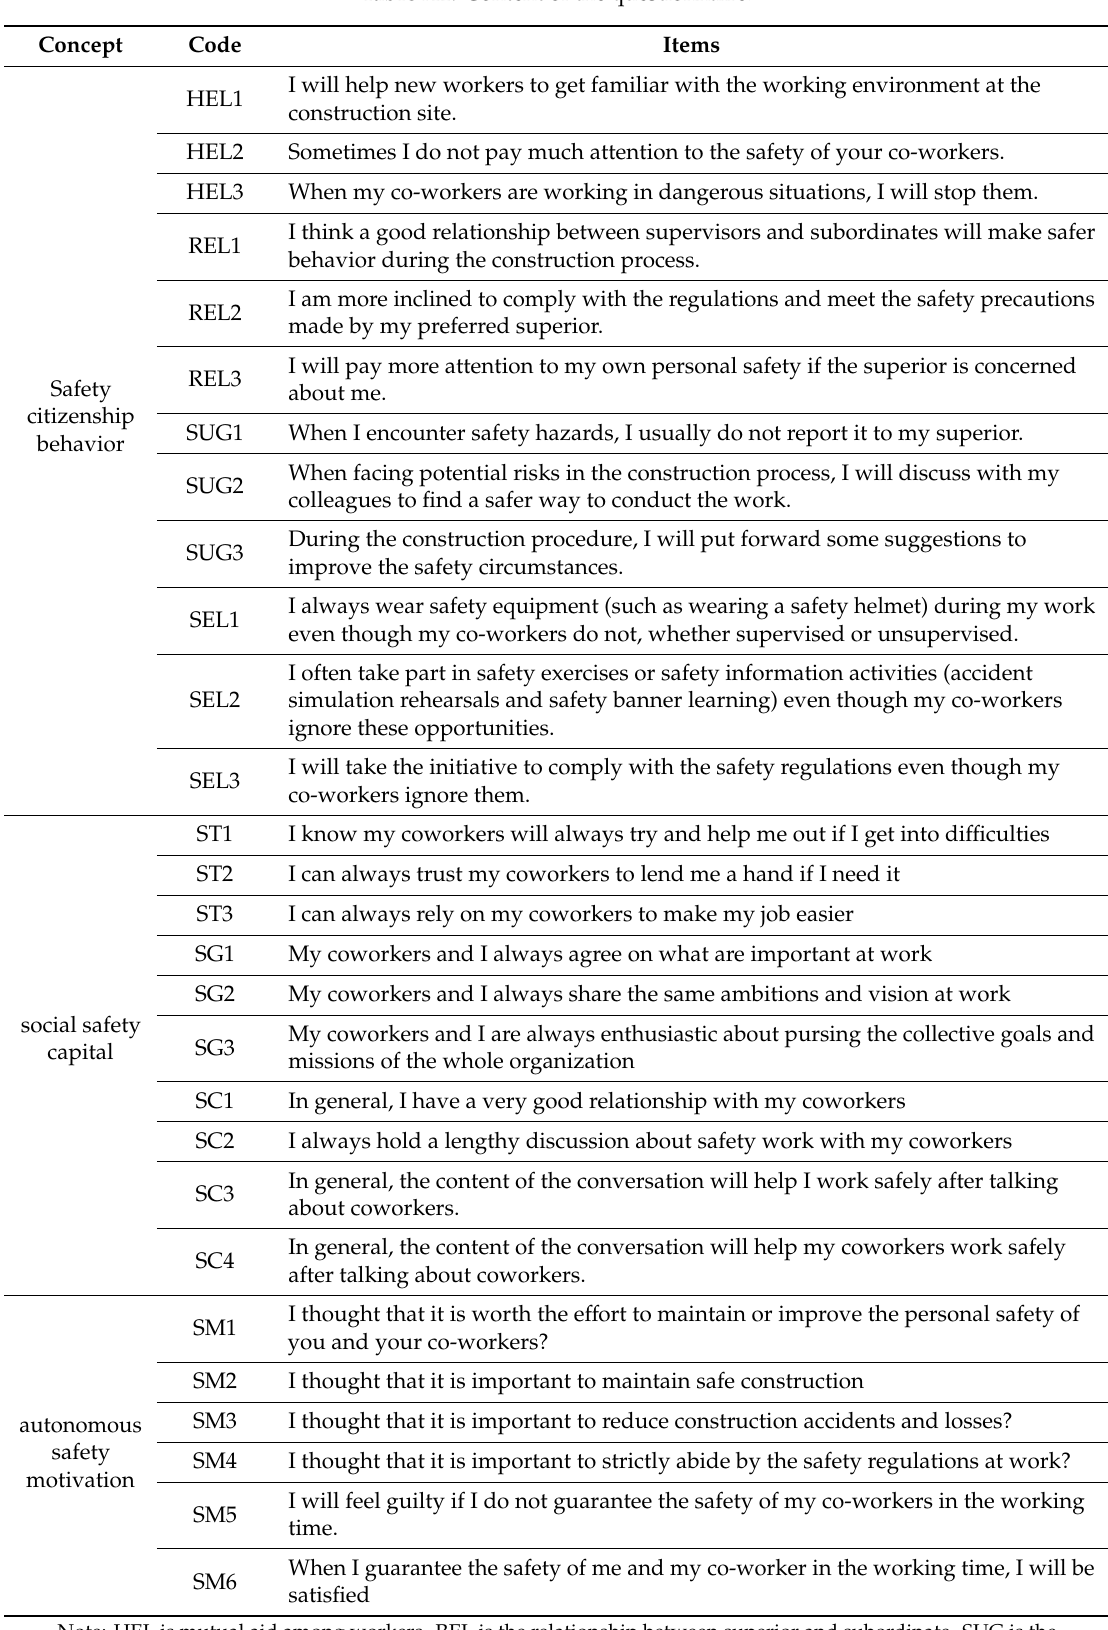
Table A1. Content of the